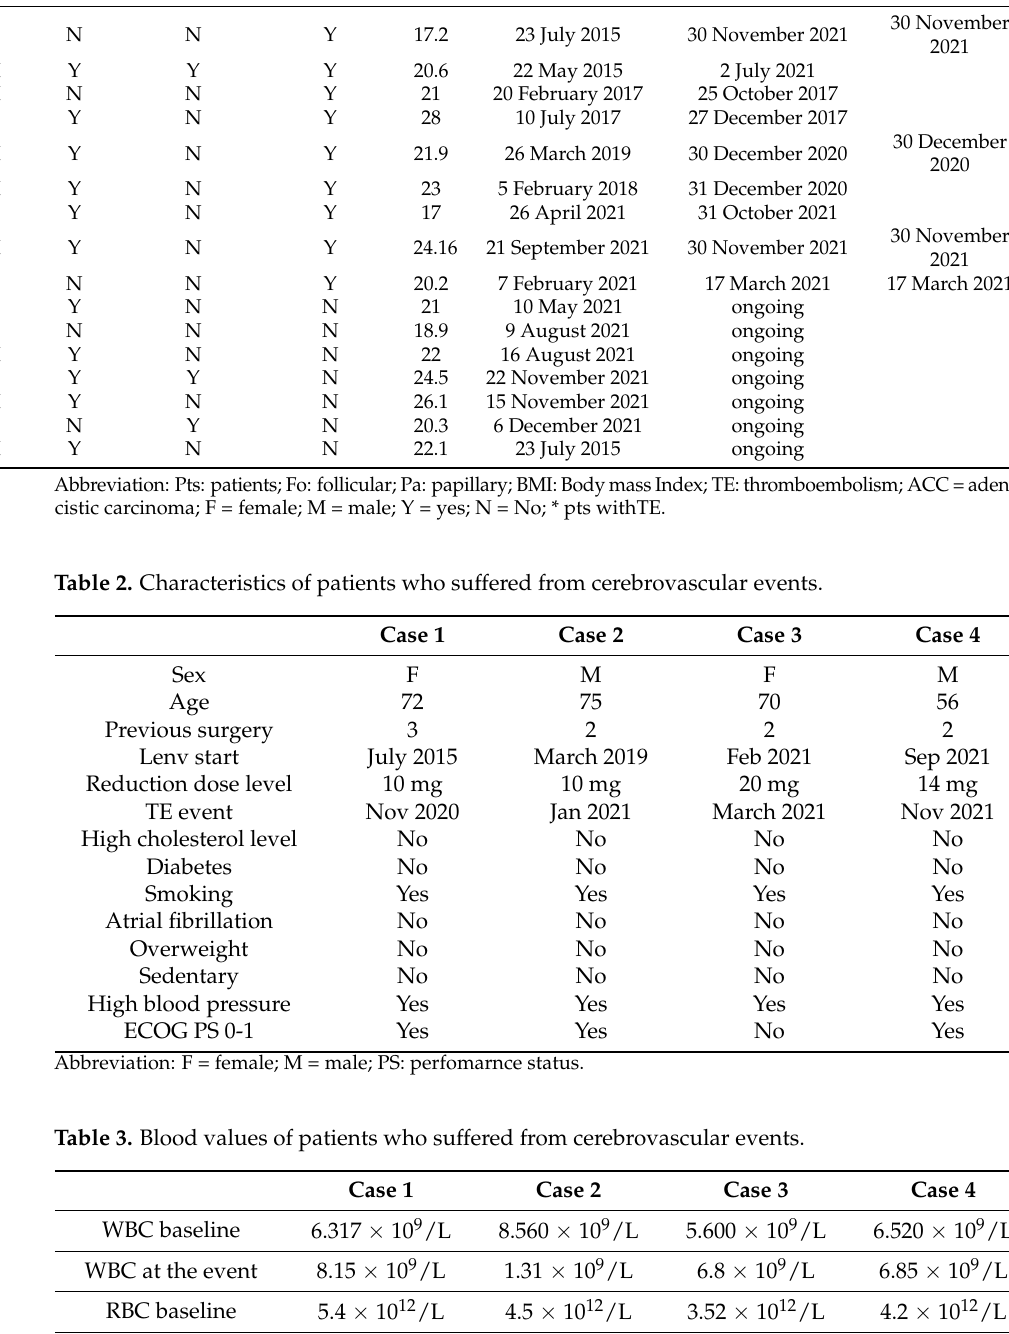
Table 1. Entire patient sample characteristics.